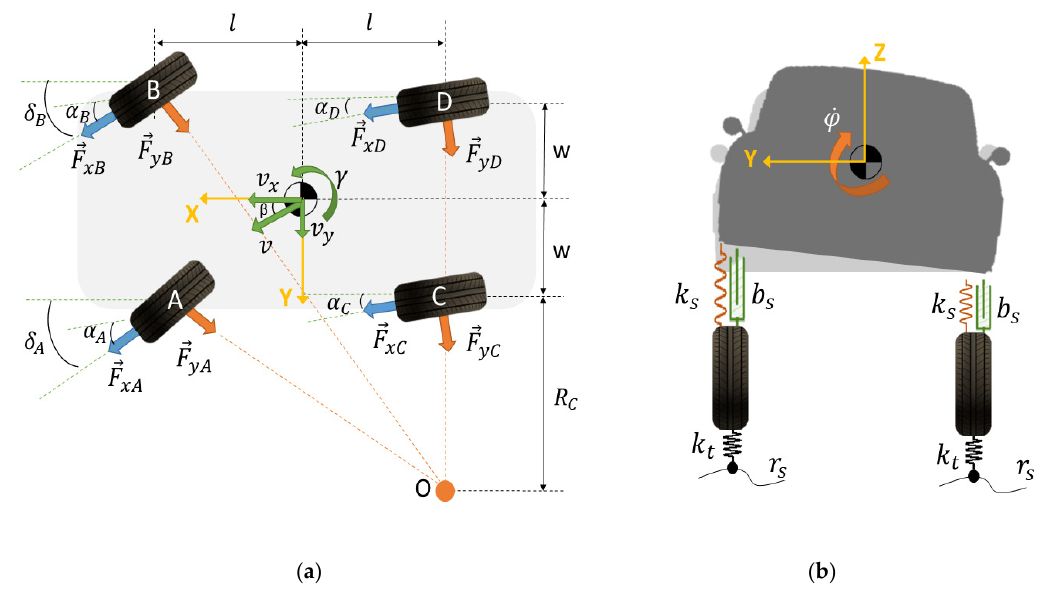
Figure 3. Vehicle dynamic model: ( a ) Top view; ( b ) Back view.